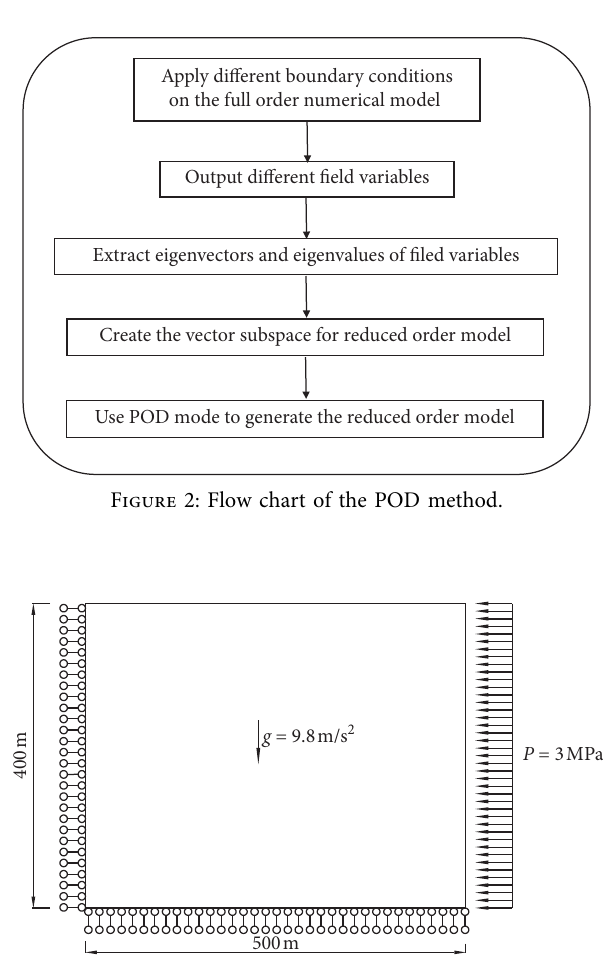
Figure 3: Schematic diagram of the calculation